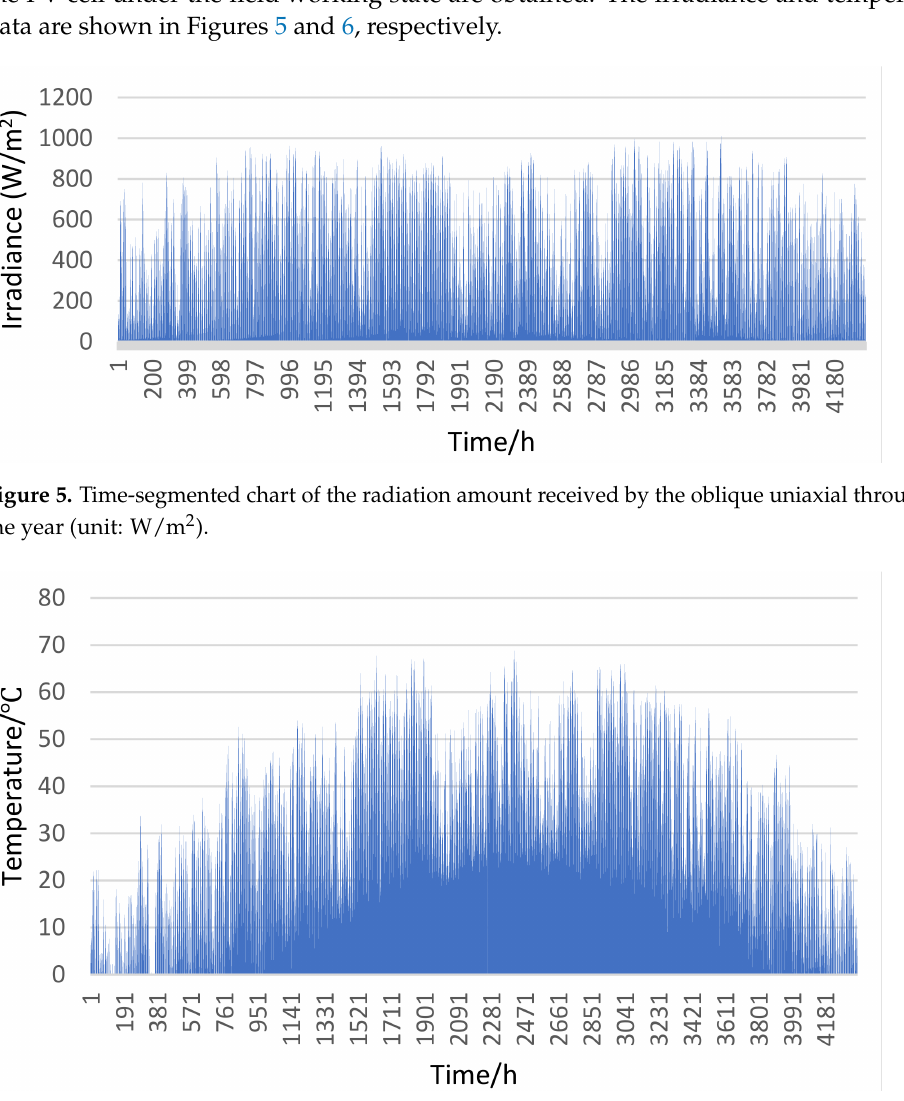
Figure 6. Time-sharing chart of the working temperature of inclined uniaxial PV cells throughout the